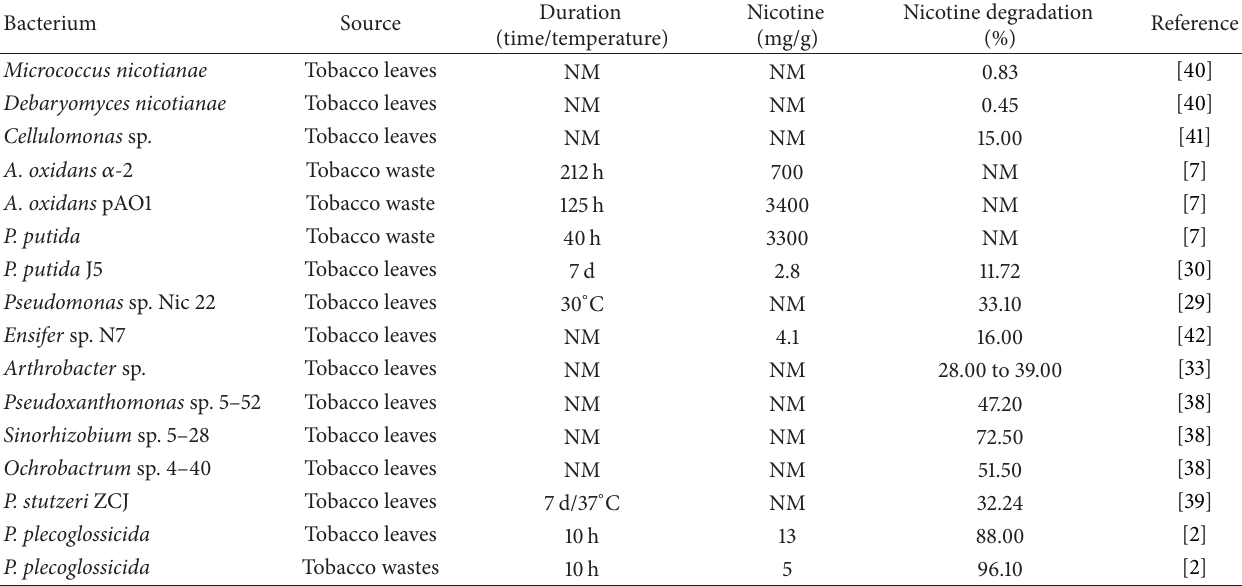
Table 2: The nicotine degradation efficiency of different nicotine-degrading bacteria on tobacco leaves and tobacco wastes.